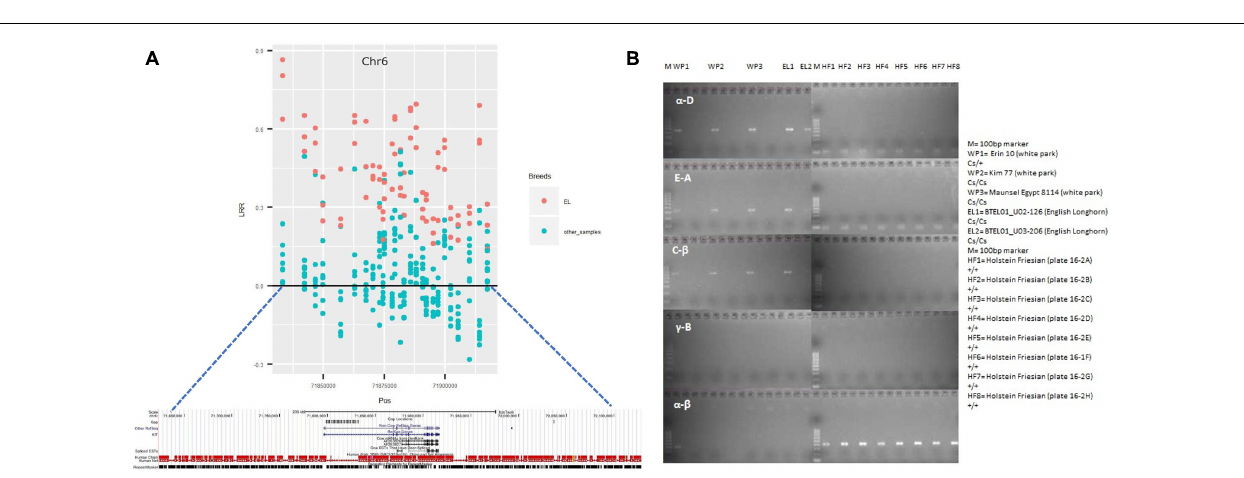
FIGURE 4 | CNVr2375 completely overlaps the Kit gene in English longhorn (EL) samples. (A) Regional SNP plot of CNVr2375. The mean LRR for each marker in EL samples are displayed in Red, while that of the remaining samples are displayed in light green. (B) Result of PCR performed to validate the presence of Cs29 allele in EL and White Park cattle, where α -D, E-A, and C- β refers to the fusion points of Cs29 allele (for more details refer to Durkin et al., 2012), while α - β refers to the wild types (+) allele. WP, White Park cattle; EL, English Longhorn cattle; M, 100 bp ladder Marker; HF,